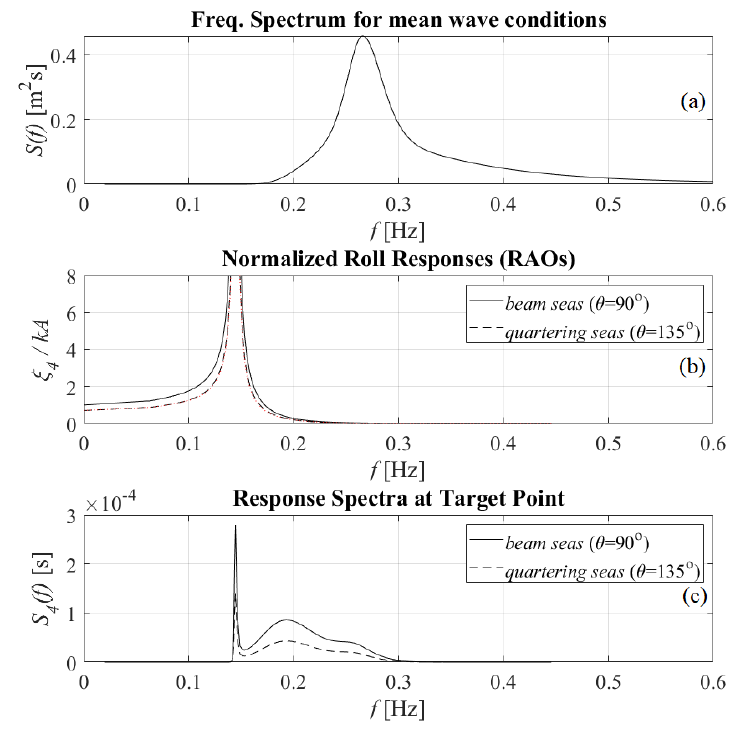
Figure 9. ( a ) Wave frequency spectra corresponding to the mean values of significant wave height and mean period of the nearshore data in the SE coastal area of Evia Island in the case of incident waves of significant wave height H s = 0.79 m and energy period T e = 3.41 s . ( b ) Roll response operators (RAOs) and ( c ) response frequency spectra of the floating pontoon-type FPV structure of length L = 45 m, breadth B = 15 m, draft 3 m, located at depth h = 15 m for beam β = 90° and quartering β = 135° seas.